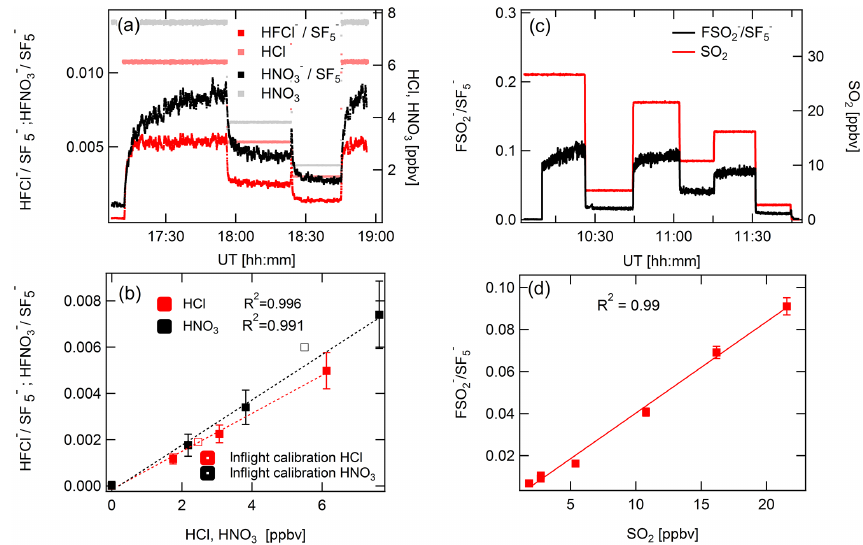
Figure 4. Laboratory calibrations of HNO 3 , HCl and SO 2 . (a) Time series of product to reagent ion ratios for HCl (red) and HNO 3 (black) are shown. While HCl reaches a plateau within a few minutes, HNO 3 needs more time for passivation. Once the sampling line is passivated, the plateau for a given concentration is reached faster for both trace gases (here after 18:45h). Additionally the concentrations of the added calibration gas are shown in light red and gray. (b) Calibration curves for HCl (red) and HNO 3 (black). The calibration is linear up to high concentrations of 6ppbv which can occasionally be found in the stratosphere. The error bars denote the precision of a single measurement. For comparison, in-flight calibrations of HNO 3 and HCl are included, represented by the empty square. Panels (c, d) are analogue to (a, b) . In contrast to HCl and HNO 3 , SO 2 is calibrated for a wider range of concentrations to account for high mixing ratios in volcanic or aircraft plumes.